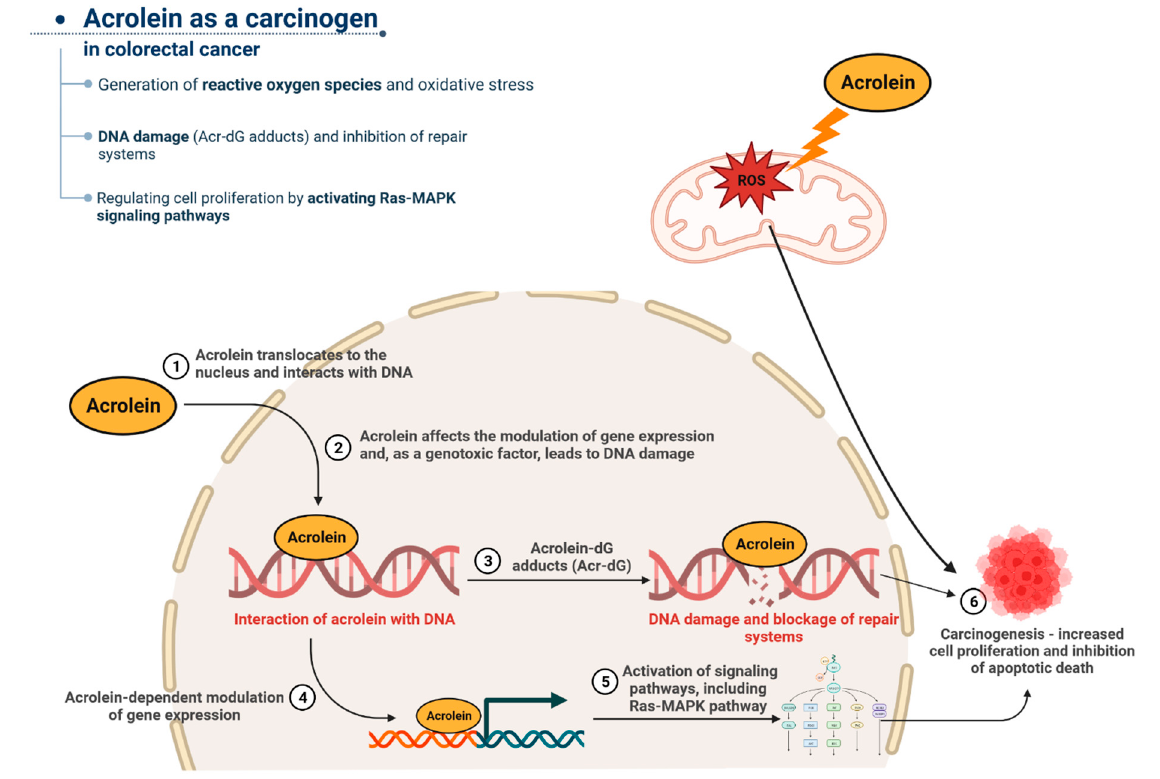
Figure 3. The role of acrolein in the development of colorectal cancer. Acrolein, by interacting with DNA, leads to significant damage and mutation of nitrogenous bases. In addition, aldehyde inhibits repair systems, affecting the fixation of mutations. By activating specific signaling pathways, acrolein induces increased and uncontrolled proliferation of cancer cells. In addition, the consequence of the excessive proliferation of cancer cells is the inhibition of apoptosis. An imbalance between the number of proliferating and dying cells leads to tissue overgrowth characteristic of